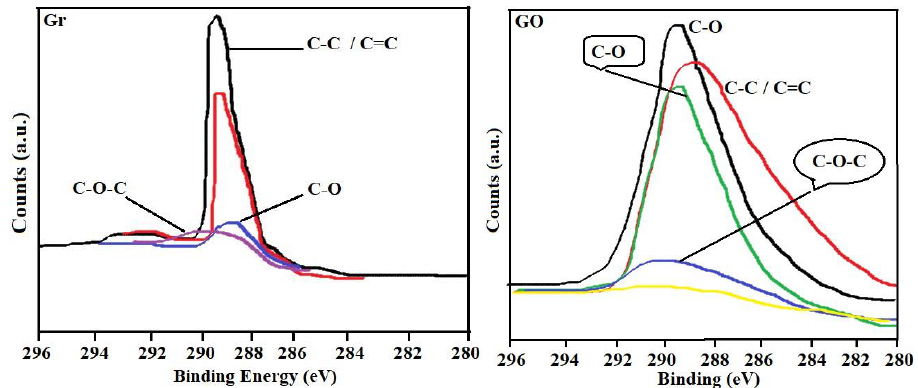
Figure 7. Binding energies of the C 1s levels spectra of Gr and GO. The peaks were deconvoluted into peaks C–C, C–O–C, C=O and COOH groups.